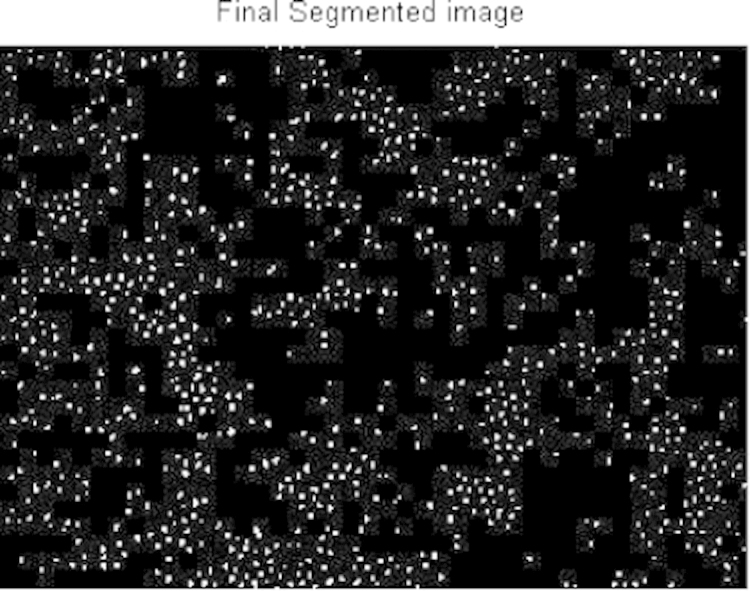
Final segmentation.